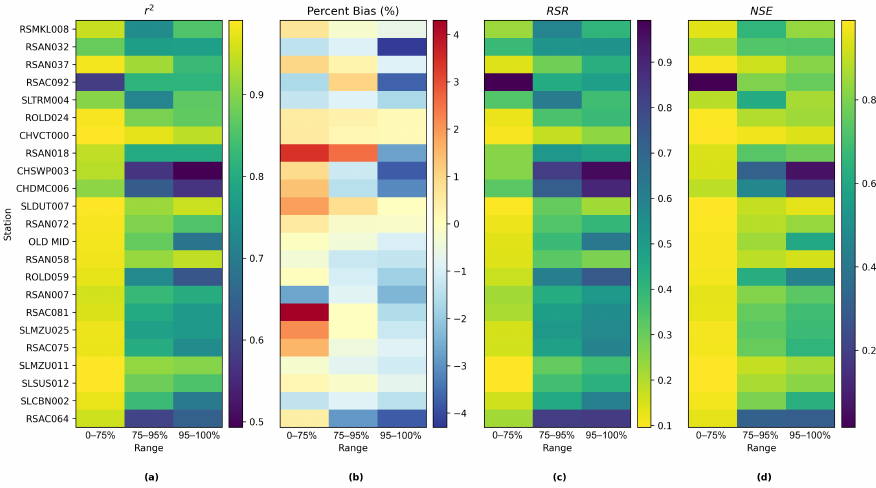
Figure 12. Heatmap showing Res-LSTM performance at different salinity ranges on the hourly time step: low–middle range (lowest 75%), high range (75 to 95 percentile), and extreme high range (highest 5%) at the study